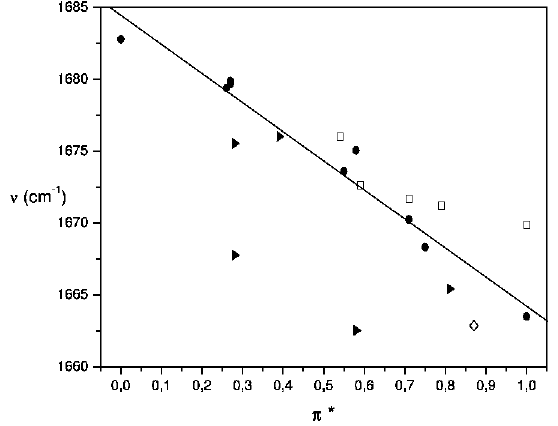
Figure 4. Plot of the frequency of the C=O stretching band for acetylferrocene versus the dipolarity-polarizability parameter of solvents ( * π ). Solvent family designations are as follows: aprotic nonpolar, dipolar, and highly dipolar (select solvents) ( ●